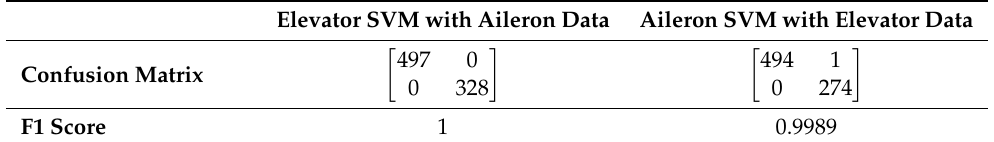
Table 6. The results for the elevator SVM model trained for 50% LOE and tested with aileron data, and the results for the aileron SVM model trained for 15% LOE and tested with elevator data.